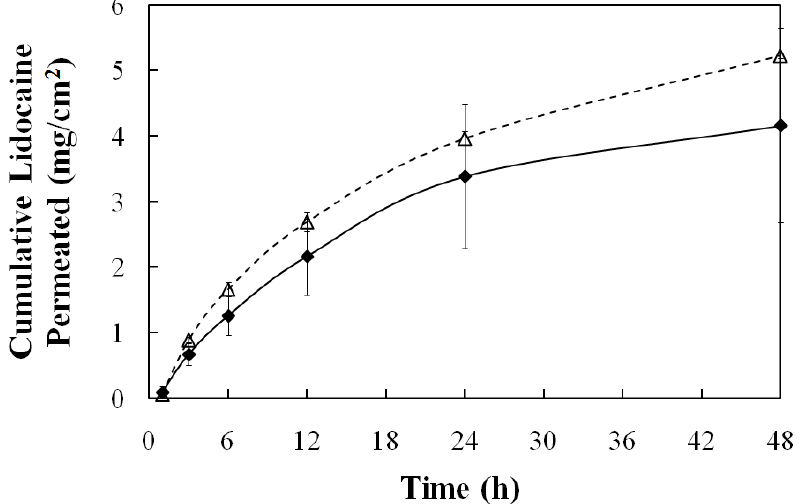
Figure 13. Permeation profile of lidocaine at 34 ± 1 °C through 100 kDa Molecular Weight Cut-Off (MWCO) acetate membrane from gelatin MBG containing 3.1% lidocaine (dose 6.1mg/cm 2 ) ( ♦ ) and from lidocaine-loaded, gelatin-free, 6% SMO μ E containing 3.9% lidocaine (dose 7.6 mg/cm 2 ) ( ∆ ). See Table 1 for additional μ E composition